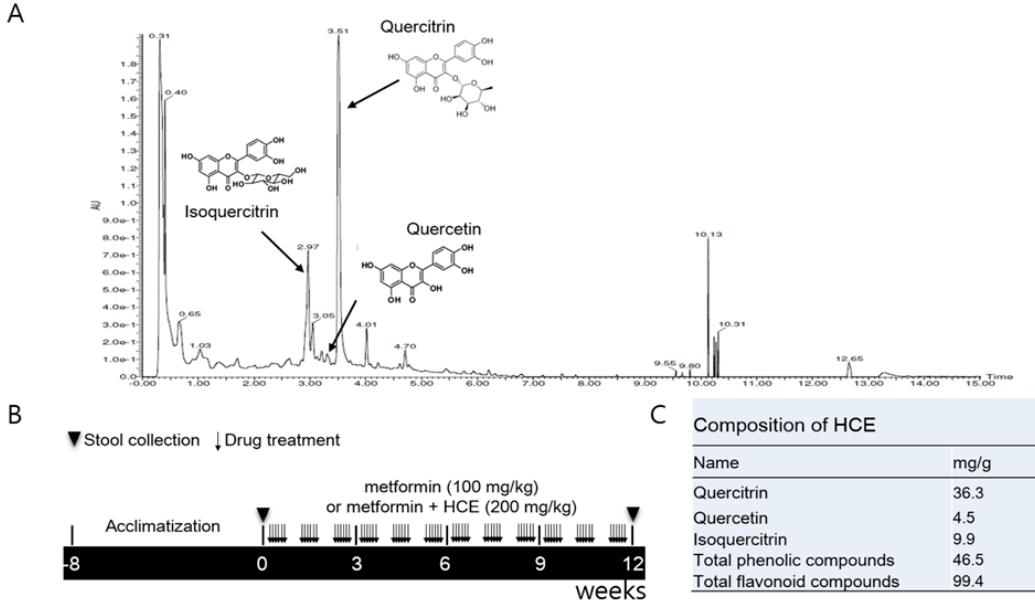
Figure 1. ( A ) Ultra-performance liquid chromatography (UPLC)-based fingerprinting of Houttuynia cordata extract (HCE) and in vivo experimental schedule. UPLC-based chromatographic analysis of HCE; ( B ) The chromatogram was produced at a wavelength of 205 nm. A synthetic scheme presents the experimental design; ( C ) The identification of the main compounds of HCE and determination of their concentrations were performed by comparison of their retention time and peak heights with those of the standards.